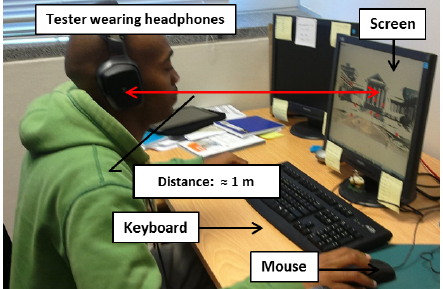
Figure 8: The test subject wearing Logitech G35 headphones while interacting with the auditory interface using input devices.